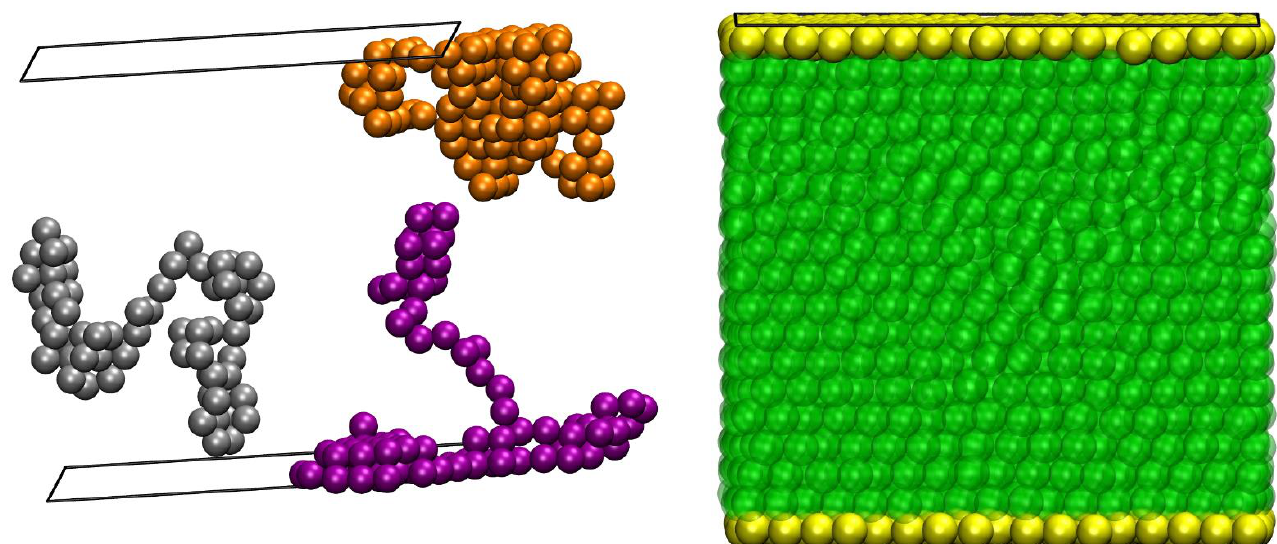
Figure 2. ( Left panel ): Snapshot showing three randomly selected chains of the 48-chain N = 100 system at ϕ = 0.61, with the coordinates of the sphere monomers fully unwrapped in the y and z dimensions. ( Right panel ): Layer identification for the CCE analysis. The atoms shown in yellow belong to the top and bottom layers adjacent to the walls, as they lie at a distance shorter than ( σ /2 + σ /4) from the nearest wall. The green atoms, shown semi-transparently, belong to the bulk volume of the system. Accordingly, the yellow and green atoms are analyzed with the 2-D and 3-D CCE norm, respectively. The black squares identify the flat, parallel hard walls in the x dimension.